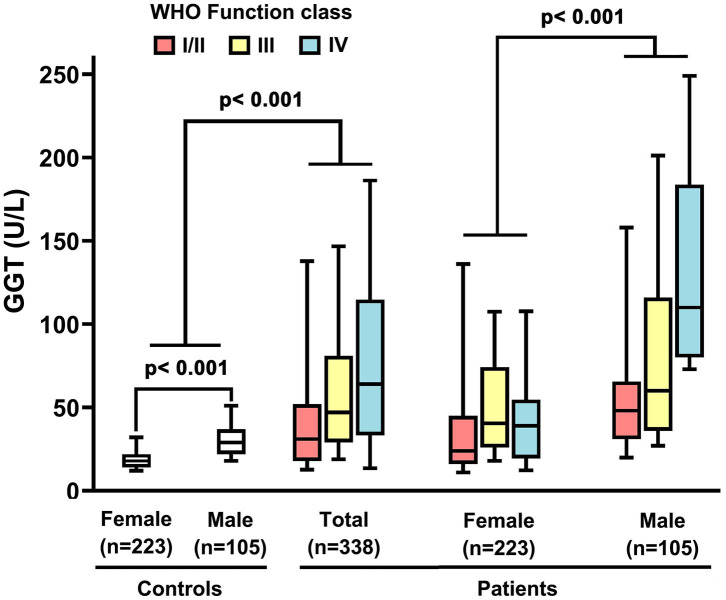
Serum gamma-glutamyltranspeptidase (GGT) concentrations in idiopathic pulmonary arterial hypertension patients, controls and different sex, associated with World Health Organization (WHO) functional class. The line through the center of the box represents the mean.